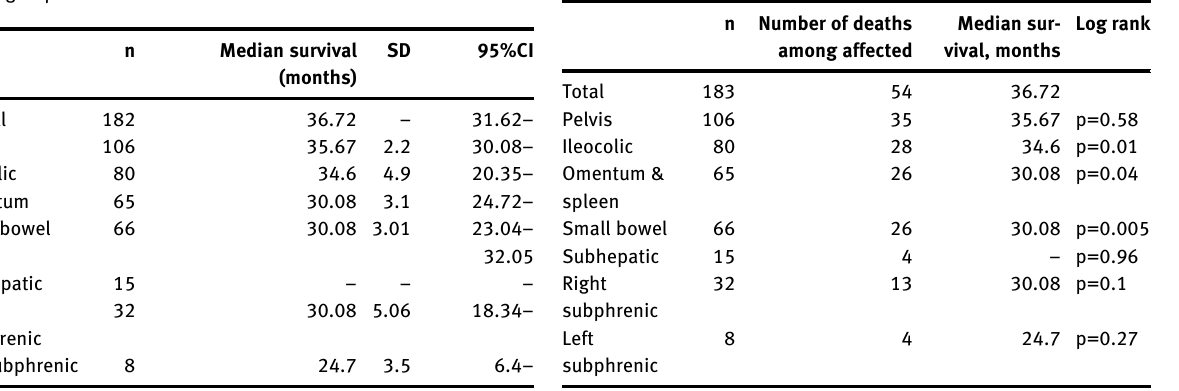
Table  : log rank test for survival in all seven sPCI